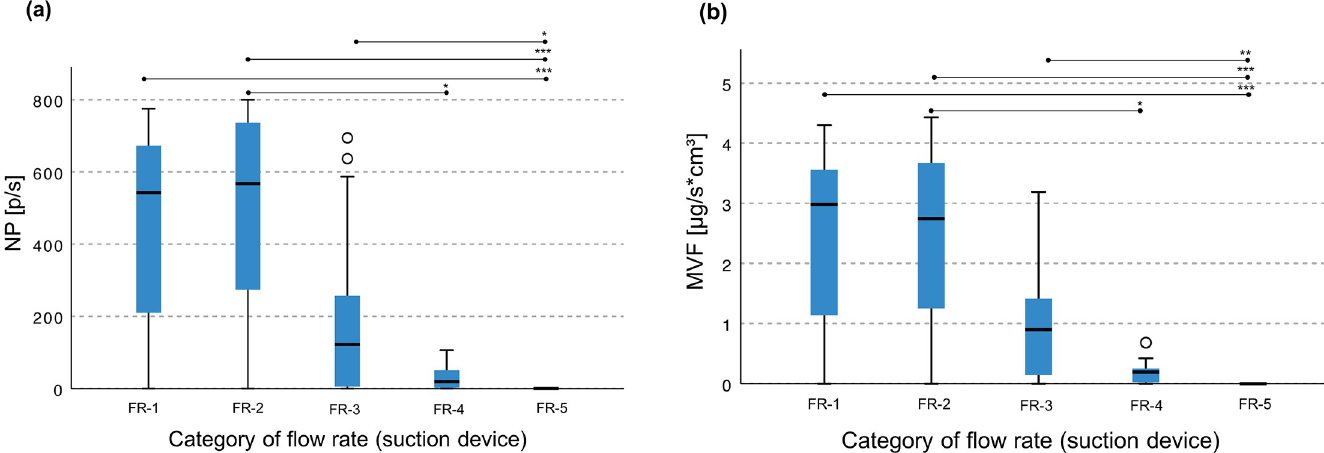
Fig 2. Comparison of all 16 mm sized cannulas independent of their intraoral position for (a) the number of counted particles/second [NP] and (b) the mass volume flow of the particles/second [MVF] per category of flow rate [FR]. Distribution of the results (mean ± SD) for the (a) number of counted particles per second (p/s) and (b) mass volume flow of the particles per second ( μ g/s � cm 3 ) according to the five categories of flow rate (FR-1: � 120 l/min; FR-2: > 120 � 160 l/min; FR-3: > 160 � 250 l/min; FR-4: > 250 � 300 l/min; FR-5: > 300 � 330 l/min) of the high-volume evacuation system (HVE) for all three cannulas (Universal Cannula, Universal Cannula Petito, Aerosol Cannula) together and independent of their position (optimal and suboptimal). Significant differences between the FR categories are shown in the upper area (Kruskal-Wallis test with � p � 0.05; �� p � 0.01; ��� p � 0.001).